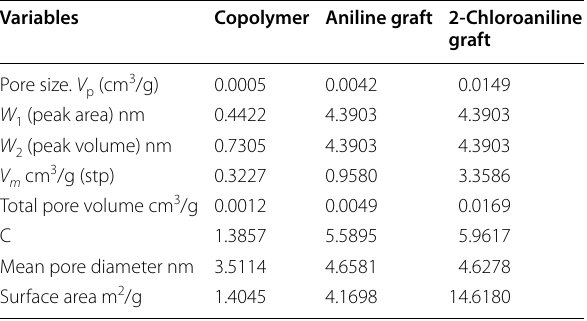
Table 3 Pore size and surface area parameters of the polymer samples Variables